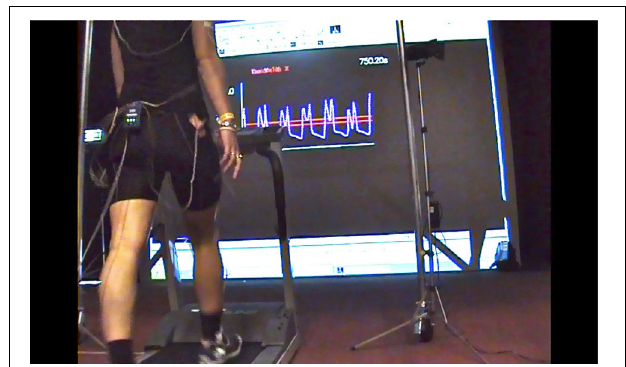
FIGURE 1 | Preferred-speed treadmill walking with visual augmented information of minimum toe clearance (MTC) provided using a real-time projection of the right foot sagittal trajectory. The MTC target band established in a baseline trial is shown as two parallel lines and MTC is the low point between the two trajectory